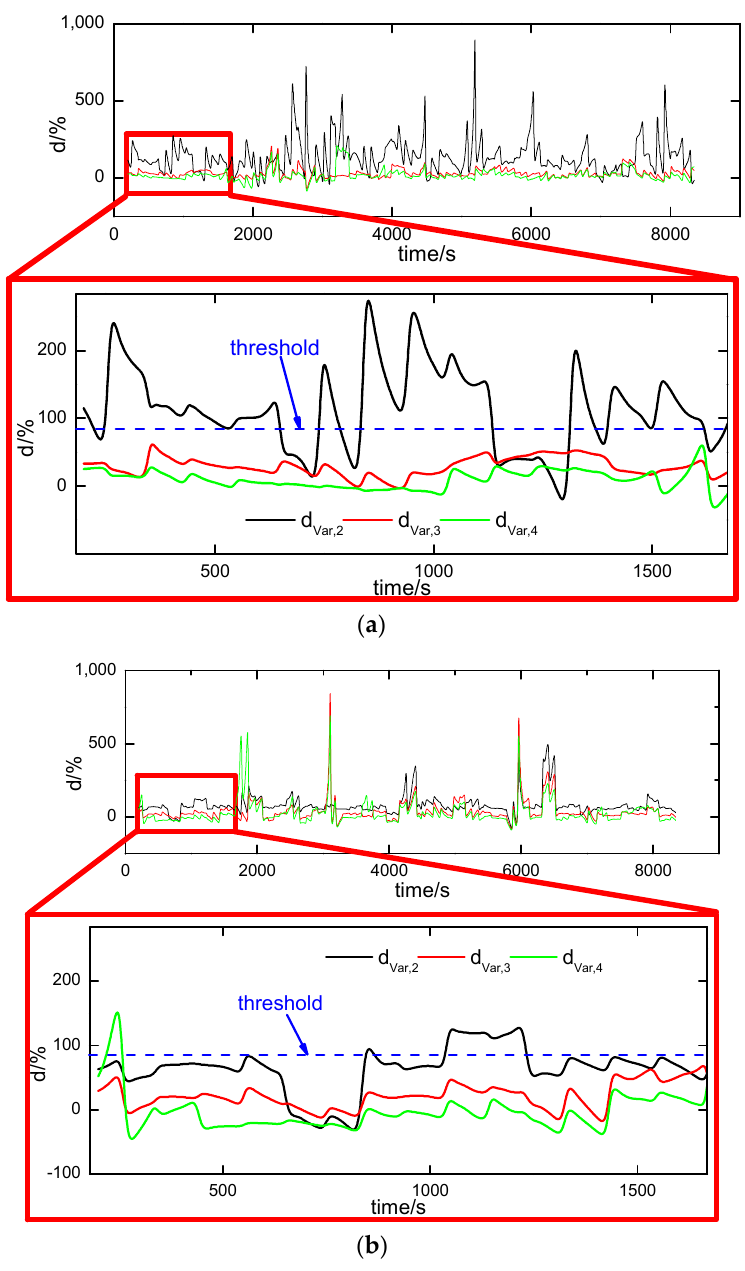
Figure 14. Deviation of PCBG resistance variance for PCBGs: ( a ) cell loose contacting fault; ( b ) cell